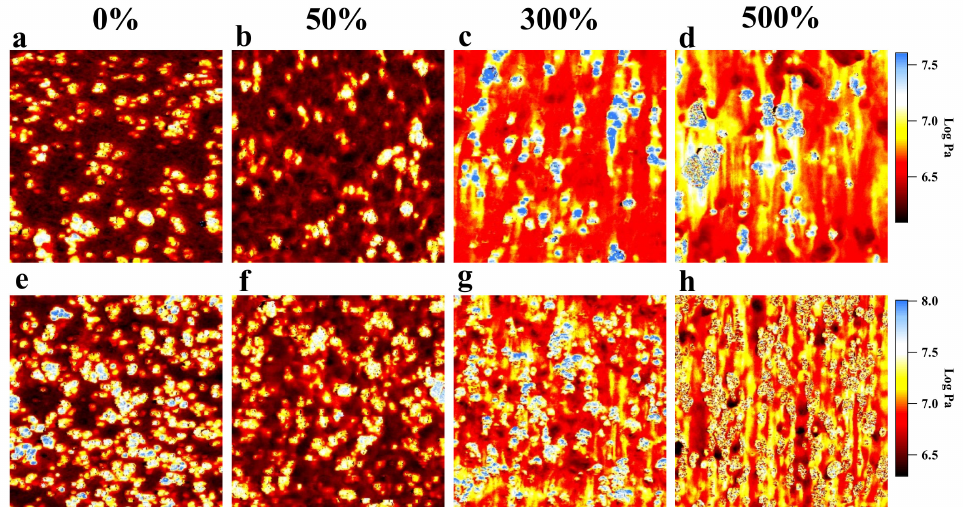
Figure 4. Modular images of CB (4.9%, 10 phr)/IR in 3.0 × 3.0 µ m areas: ( a ) unstretched; ( b ) stretched to λ = 50%; ( c ) stretched to λ = 300%; ( d ) stretched to λ = 500%. Modular images of CB (13.2%, 30 phr)/IR in 3.0 × 3.0 µ m areas: ( e ) unstretched; ( f ) stretched to λ = 50%; ( g ) stretched to λ = 300%; ( h ) stretched to λ =